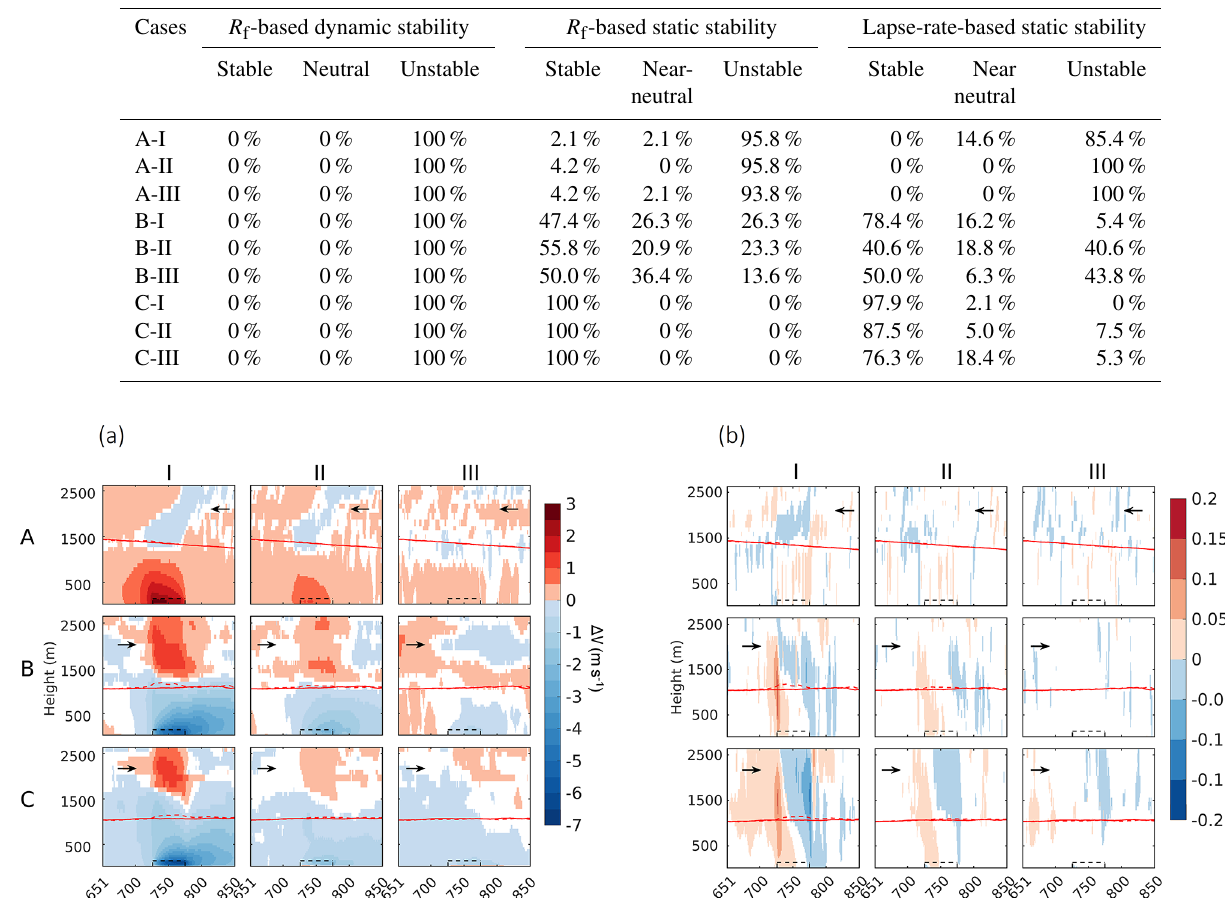
Table 3. Percentage occurrence of different stability conditions.